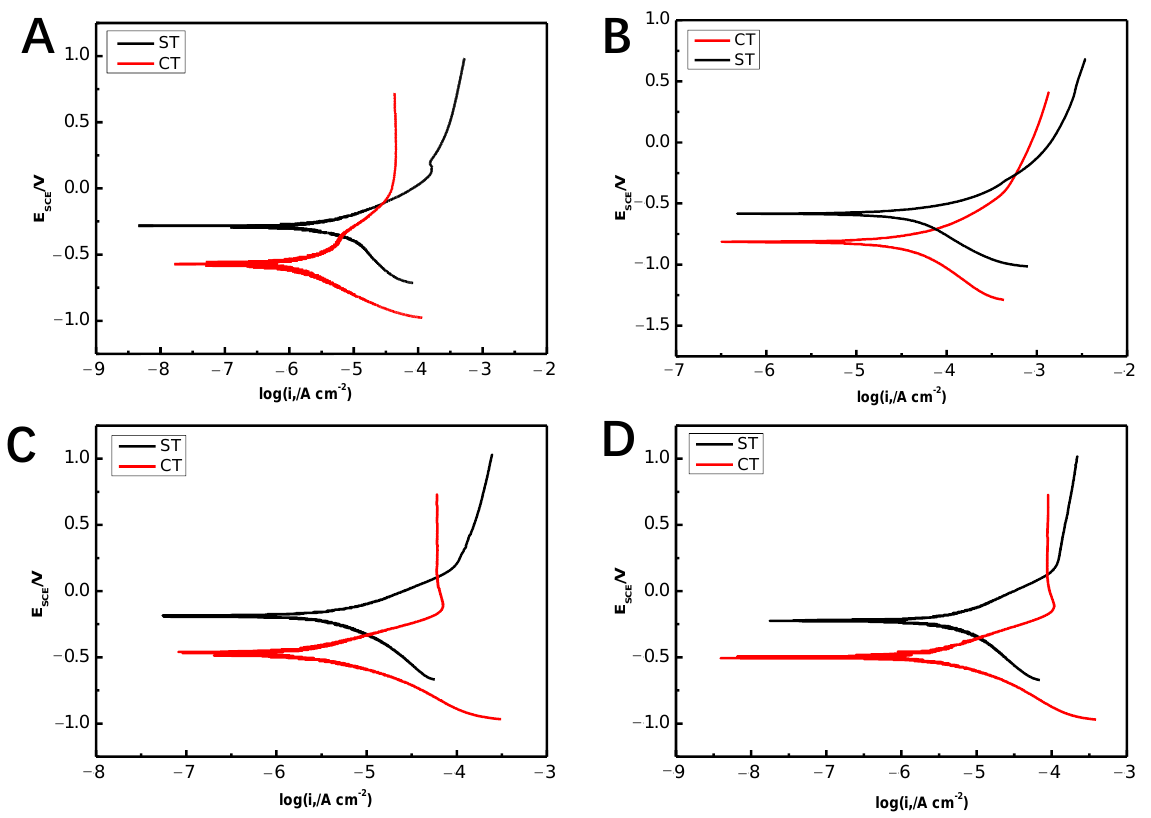
Figure 3. Potentiodynamic curves for ST and CT in ( A ) 3.5 wt.% NaCl solution, ( B ) 15 wt.% NaCl solution, ( C ) PBS buffer solution and ( D ) SBF solution.